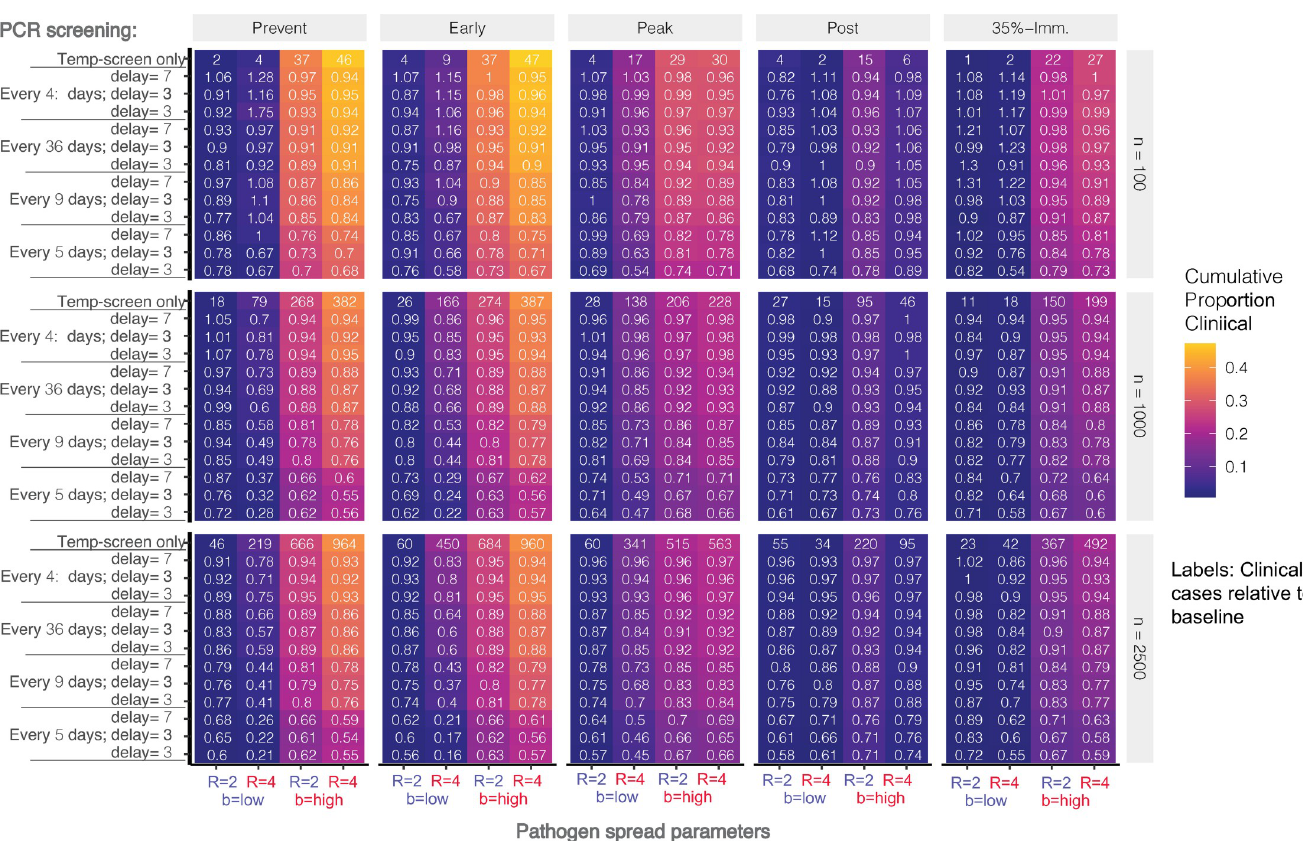
Fig 7. Proportion of expected clinical cases averted by PCR-screening relative to baseline of temperature screening alone. Results are stratified according to stage at which PCR-screening is implemented (Prevention, Early, Peak, Post, 35% Immune), workforce size (n = 100, 1000, 2500), and high/low workforce R and background transmission rates. Absolute number of expected clinical cases under the baseline is labeled in the top line of each colored block, and each cell label shows the clinical cases relative to baseline ( Cases scenario / Cases baseline ). Colored shading indicates the cumulative proportion of the workforce that experience clinical disease.